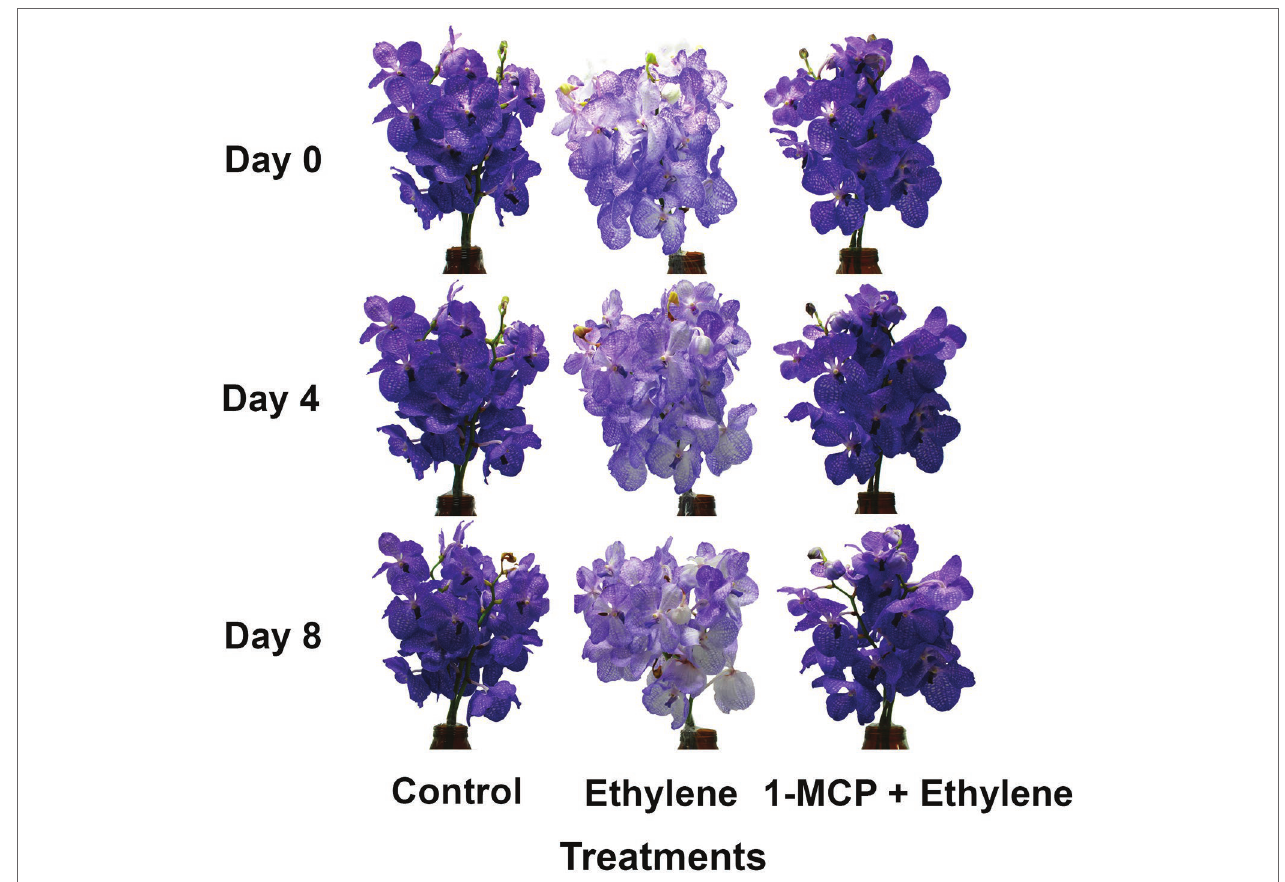
FIGURE 2 | Effect of ethylene and 1-MCP pre-treatments on the visual appearance of inflorescences during vase life of cut Vanda ‘Sansai Blue’ flowers after treatment application. The inflorescences were exposed to air (control), 10 μl L −1 ethylene for 24 h, or to 0.2 μl L −1 1-MCP for 6 h followed by 10 μl L −1 ethylene for 24 h at 21 ± 2 ° C, and then placed in the observation